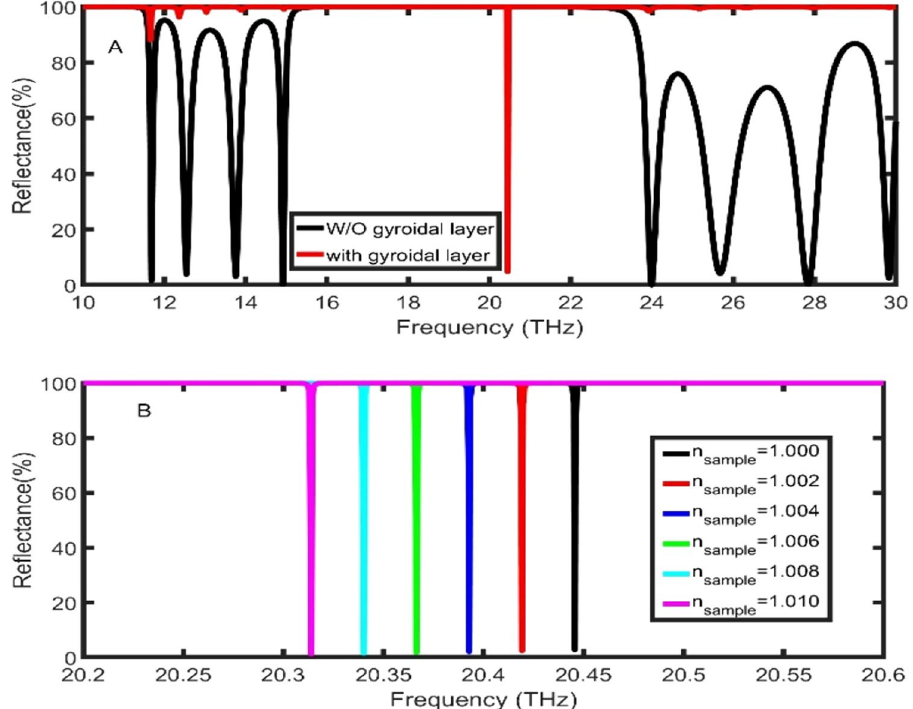
Figure 2. The reflectance spectra of the proposed PSi-PC structure (A) without GGr (black line) and with GGr (red line) at nsample = 1.00, (B) with GGr at different values of sample layer index of